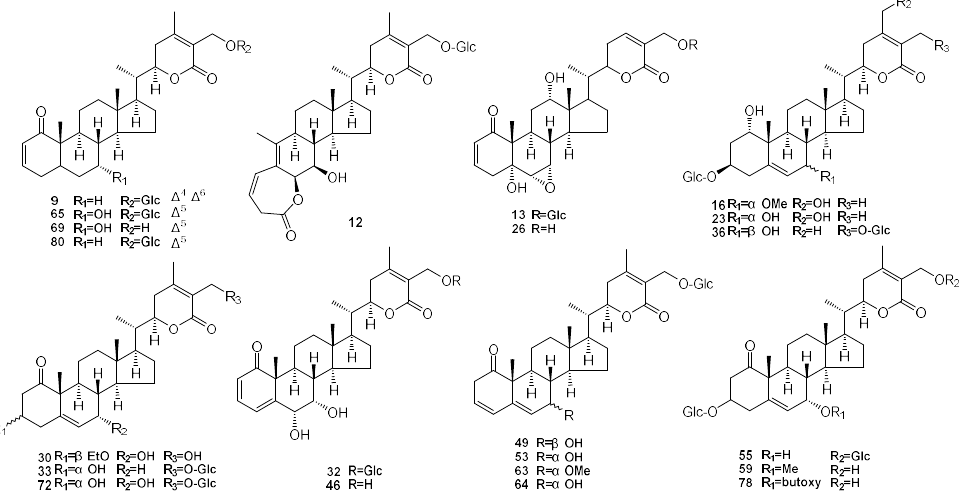
Figure 4. Chemical structures of the 22 withanolides.